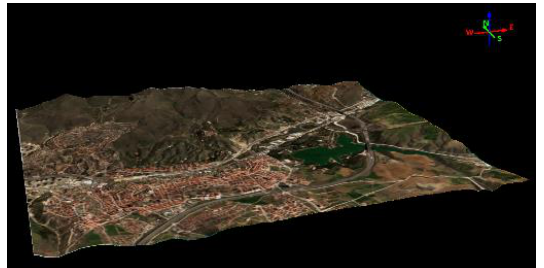
Figure 18. The DTM of the study area textured with the Sentinel-2 image.